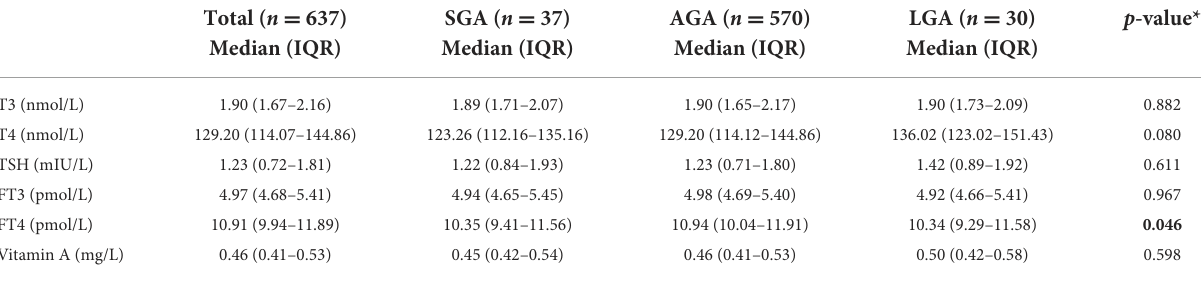
TABLE 2 Distribution of maternal thyroid hormones and vitamin A levels in early pregnancy among SGA, AGA, and LGA newborns.